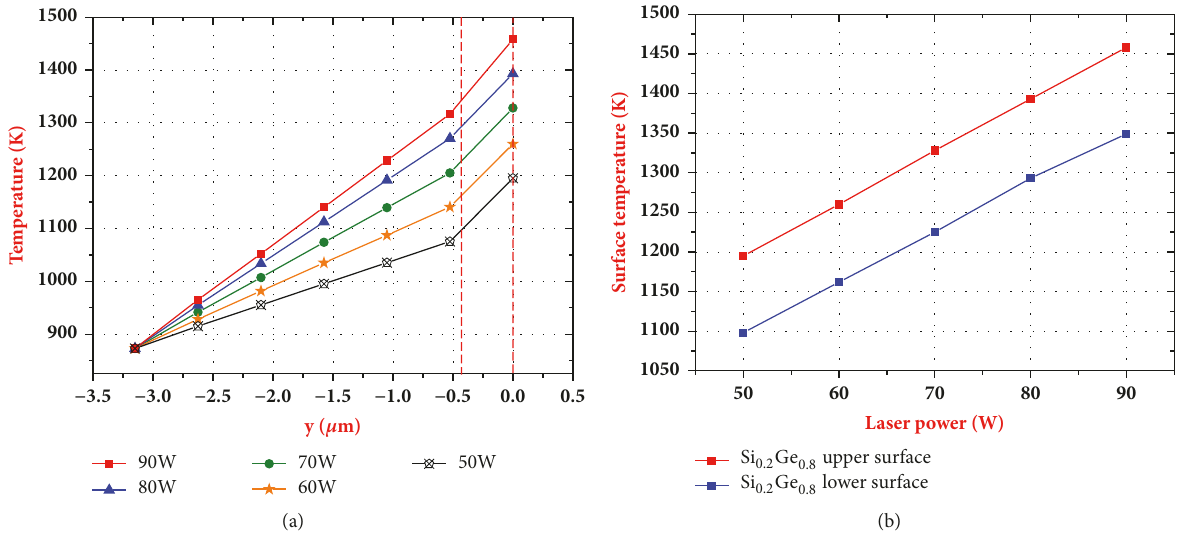
Figure 7: (a) Longitudinal temperature changes of the sample at x = 0 with different laser powers. The vertical lines delimit the area of Si 0.2 Ge 0.8 layer. (b) Peak temperatures of Si 0.2 Ge 0.8 upper surface and lower surface as a function of laser power.